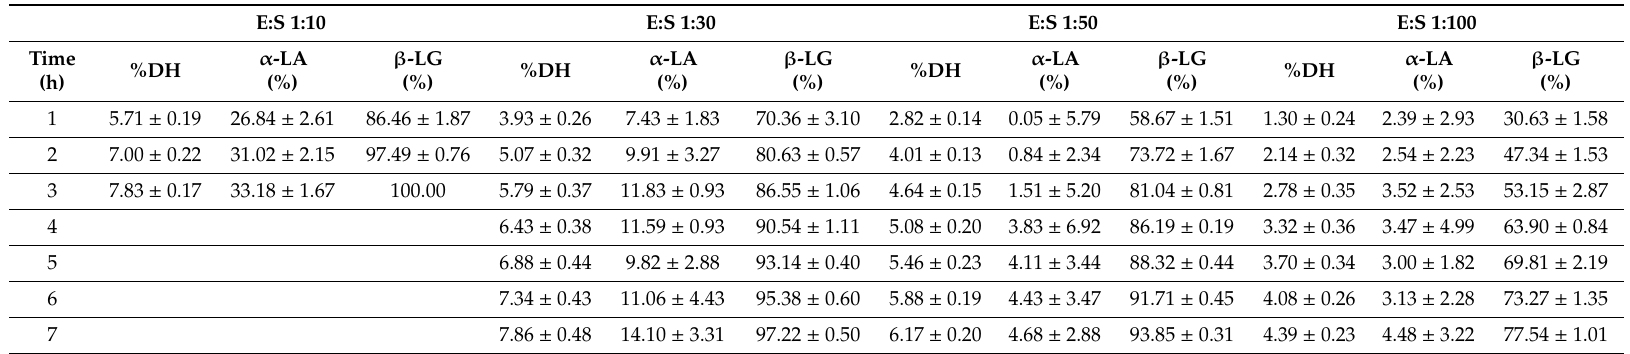
Table 2. Comparison of overall degree of hydrolysis (%DH) and extent of hydrolysis (%) of β -lactoglobulin and α -lactalbumin at di ff erent enzyme: Substrate ratios (E:S 1:10, 1:30, 1:50 and 1:100) and incubation times (1 to 7 h) during the targeted hydrolysis of whey protein isolate with trypsin during incubation at 25 ◦ C and pH 8.5. Mean values and standard deviation ( n = 3) were derived from the results of triplicate